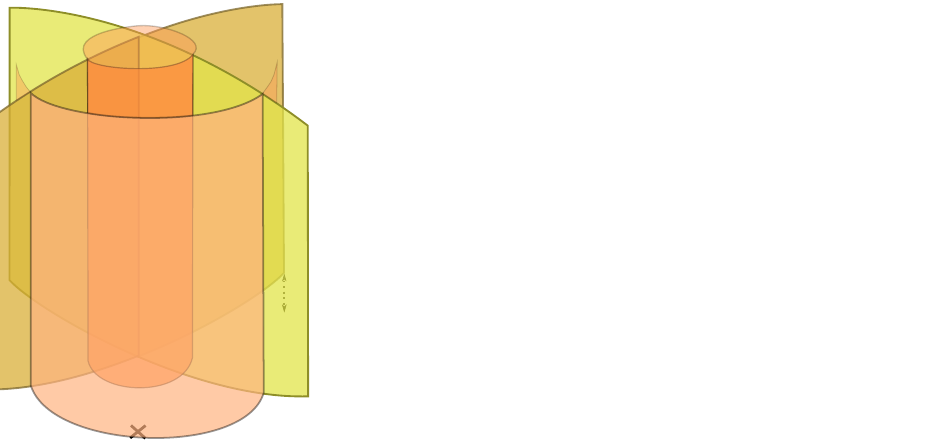
Figure 5. Three-dimensional laser focus scan pattern used for the fragmentation of cataractous lenses.